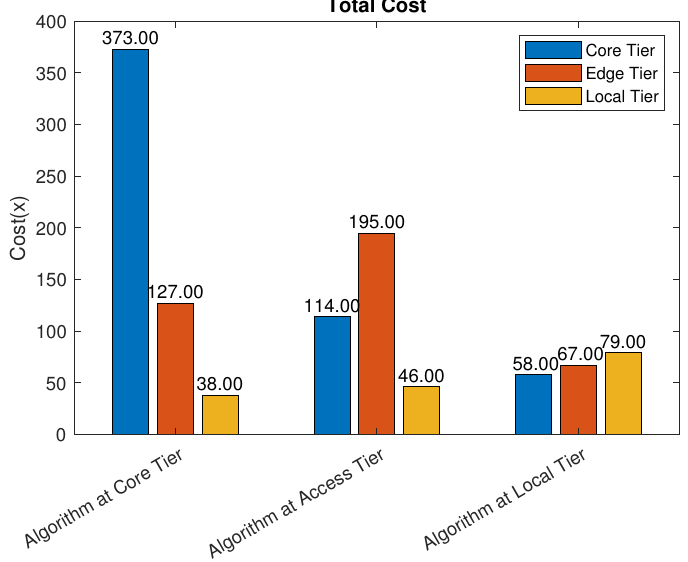
Figure 10. Total cost: without the